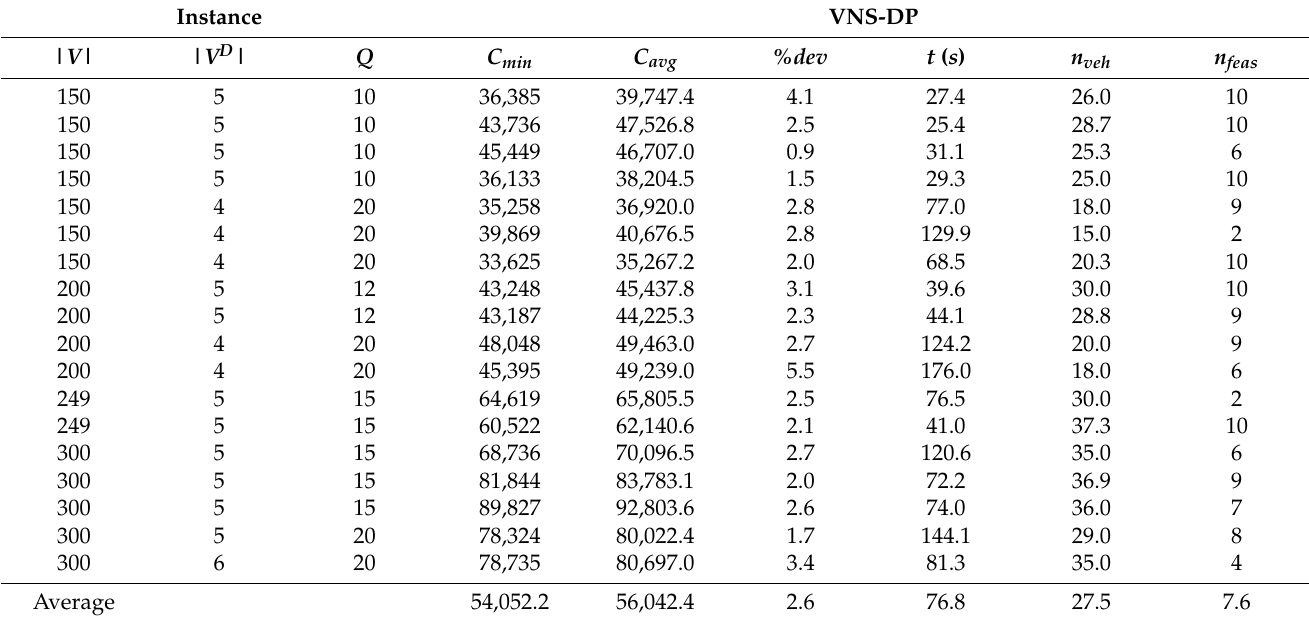
Table 8. Results for VNS-DP for large-size random instances.